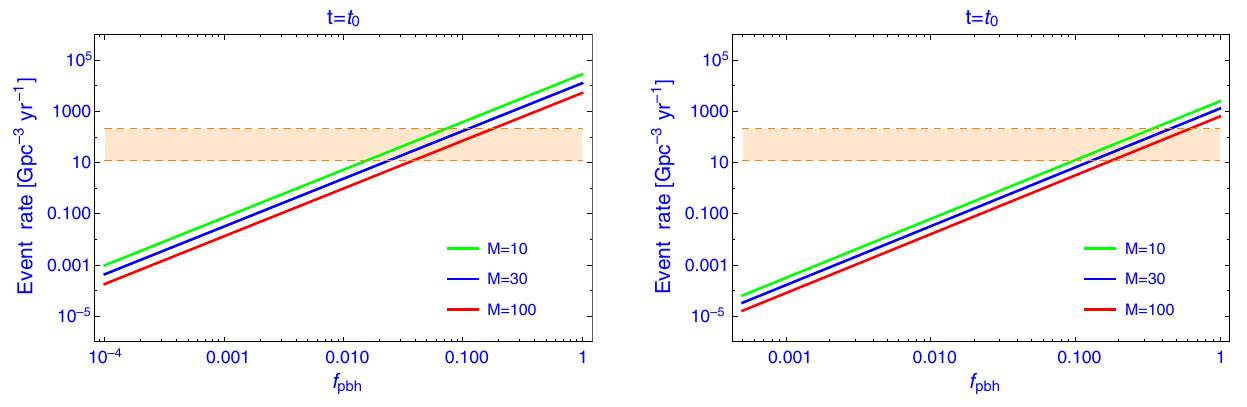
Fig. 5 Event rate of third merger of PBH binaries with the mass M = 10(green),30(blue)and100(red)in M (cid:2) atthepresenttimeasafunction of the PBH abundance. The merger rate R = 12–213 Gpc − 3 year − 1 , inferred by the LIGO and Virgo Collaboration, is shown as the shaded region colored orange